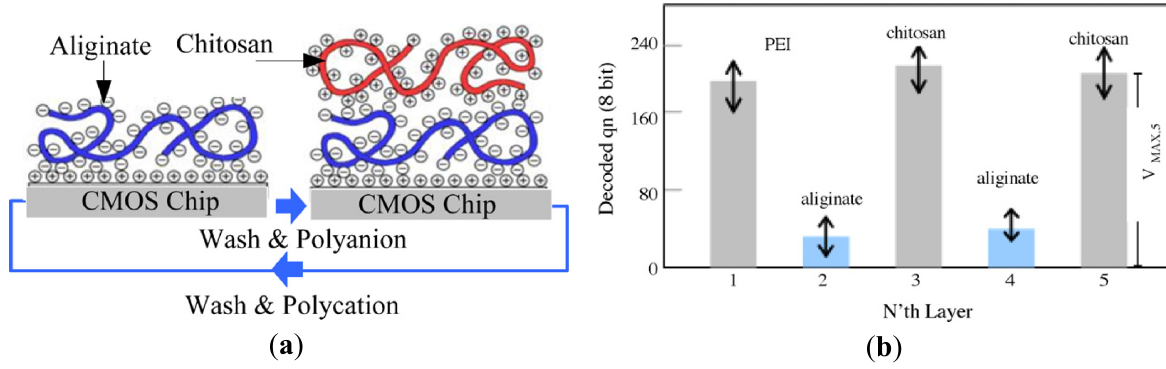
Figure 2. ( a ) Deposition sequence of PEI/(alginate/chitosan) ( b ) Detection of the deposition of polyelectrolytes on the chip; The y axis ( q response from the device when the polyelectrolytes are deposited on it in terms of the bit stream that results from converting the signal from analog to digital. Reprinted with permission from [24]. © 2008, Elsevier.